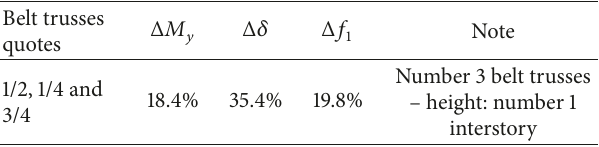
Table 10: Percentages of response reduction achieved by the solution proposed in Case 3, n. 1 interstory in height and n. 4 lines in horizontal length: Case 3.